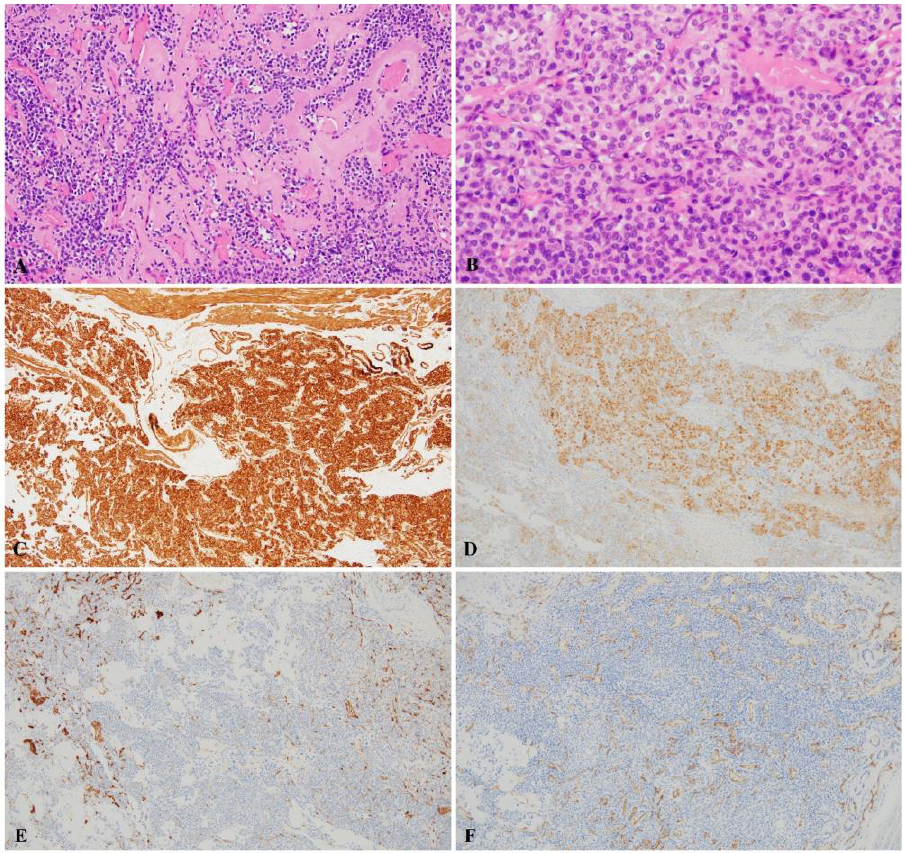
Figure 2. Bronchoscopy revealed a 1.5 cm sized polypoid endotracheal mass with a hyperemic mucosal surface in the mid portion of the trachea.